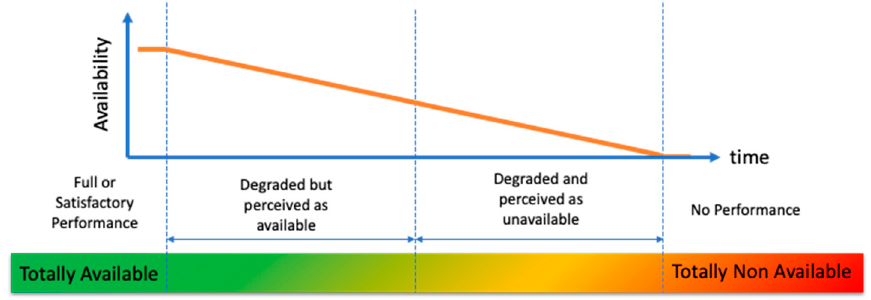
Figure 2. The concept of gradual performance degradation process (adapted from [14]).